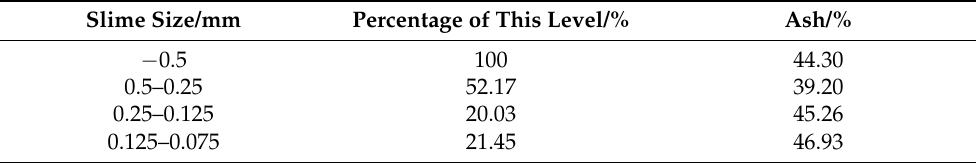
Table 4. Analysis of the percentage of each particle size and ash content of coal